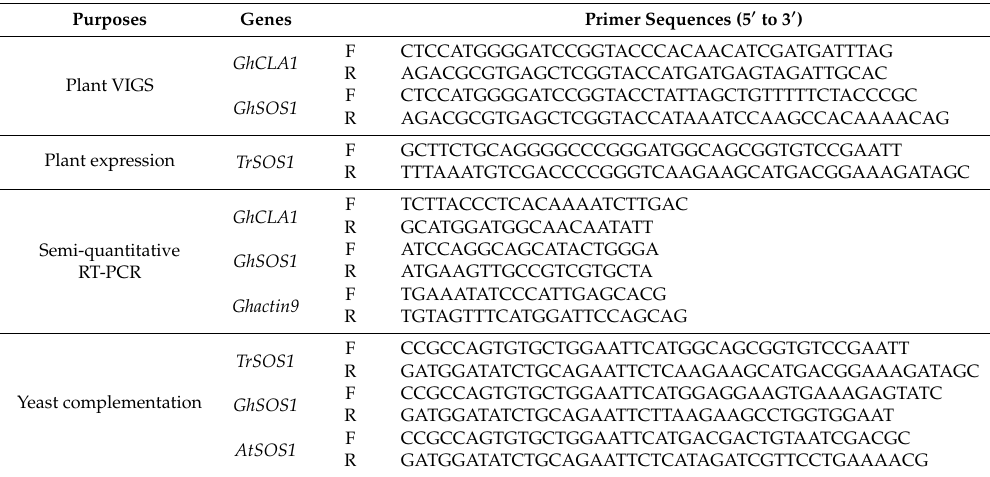
Table 1. Primers for gene